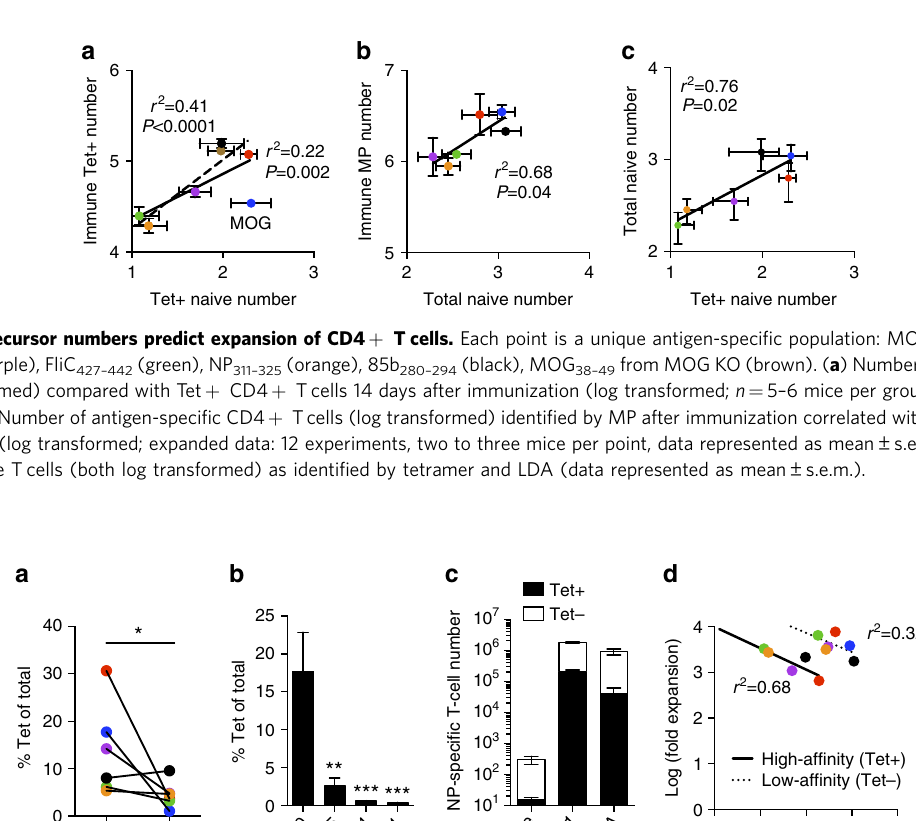
signifying the two populations of cells compete within themselves comparably (Fig. 5d). Therefore, TCR:pMHCII affinity does not control the accumulation of CD4 þ T cells during the immune response, and instead immune activation selects for a diverse range of affinities during primary immune expansion. 6 NATURE COMMUNICATIONS|7:13848|DOI: